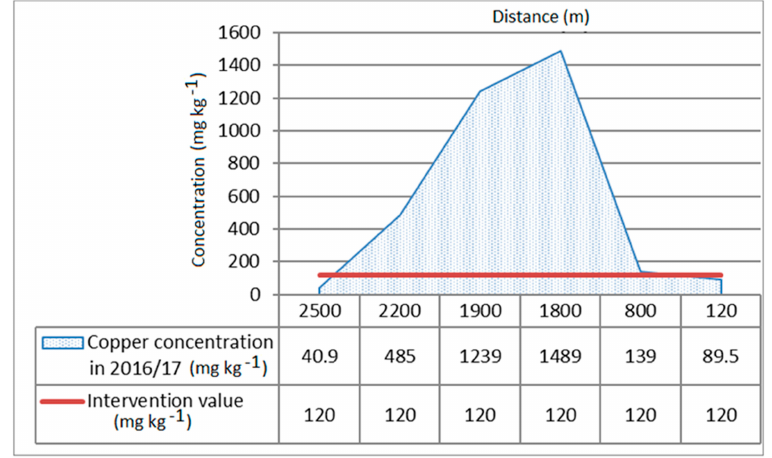
Figure 4. Field research of copper concentration along the canal with designated intervention value.